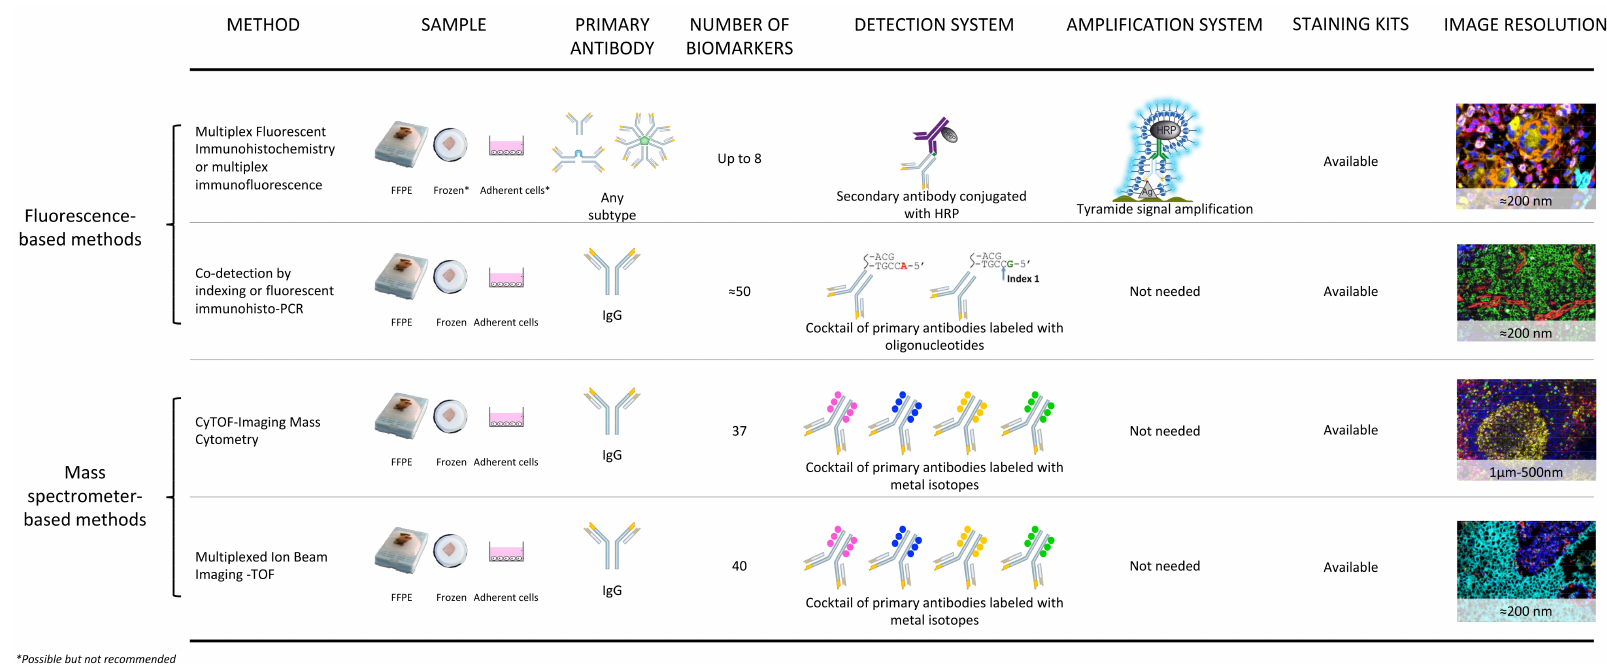
Figure 1. Technical comparison of fluorescent-based platforms and mass spectrometer-based platforms for digital image analysis. Digital image analysis for cancer research applications can be achieved with several methodologies. Some of them have advantages over others depending on the sample available, the specific antibodies against biological markers of interest, the detection system needed, and in some cases, the amplification of the signal for poorly expressed